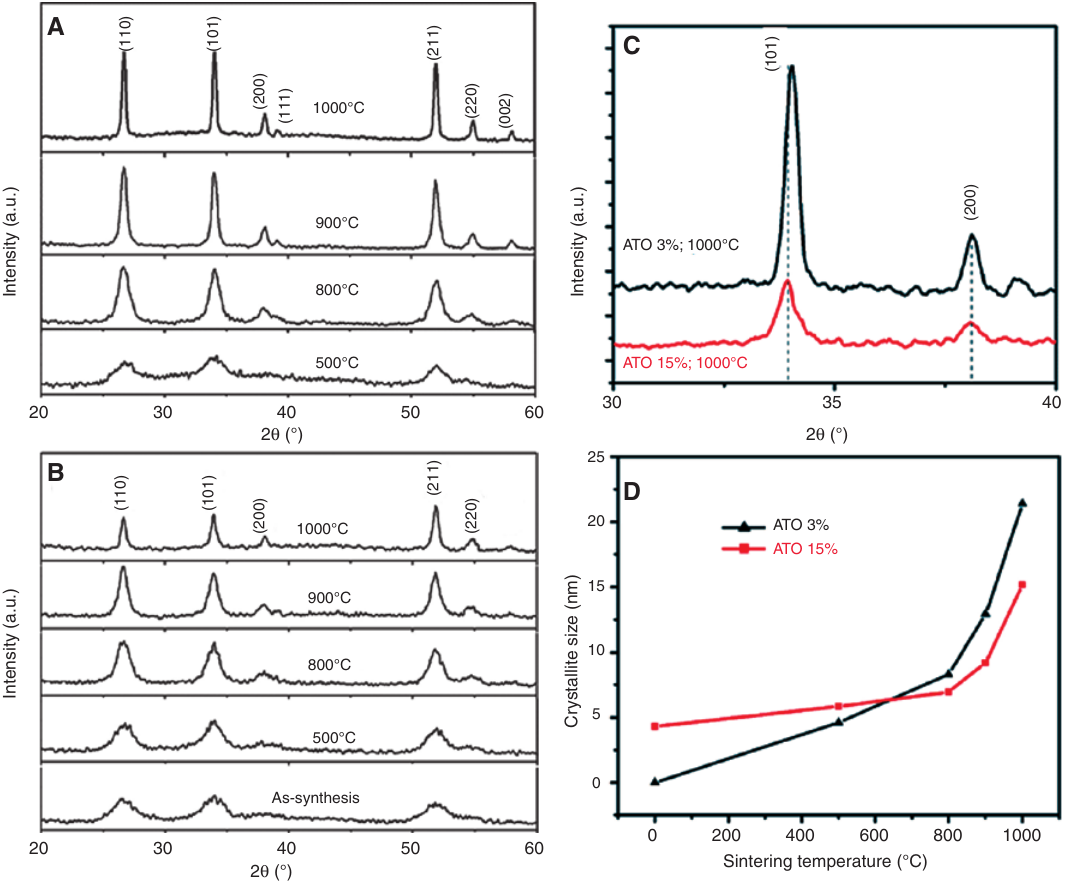
Figure 5: X-ray diffraction (XRD) pattern of antimony-doped tin oxide (ATO) nanoparticles (NPs) 3% and 15% as a function of sintering tem- perature (A) and (B) the {101} shifted peak of sintered at 1000 ° C ATO 3% and 15% and (C) crystallite size vs. sintering temperature of ATO 3% and 15%.